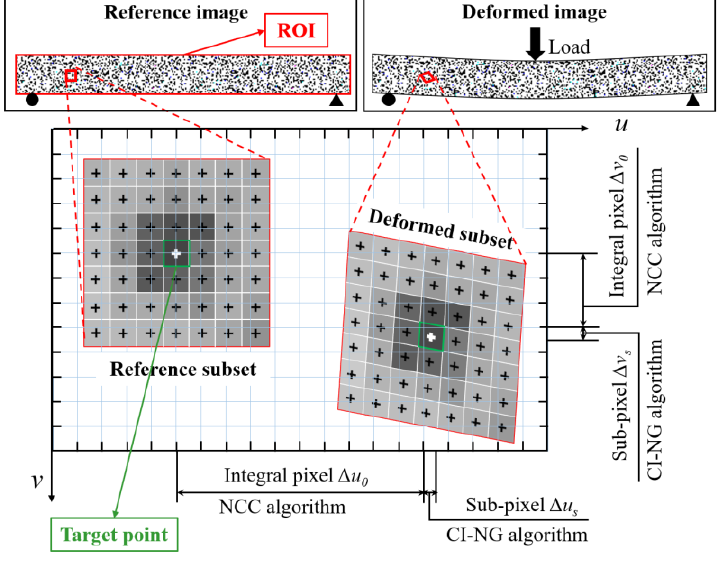
Figure 1. Digital image correlation (DIC) algorithm.